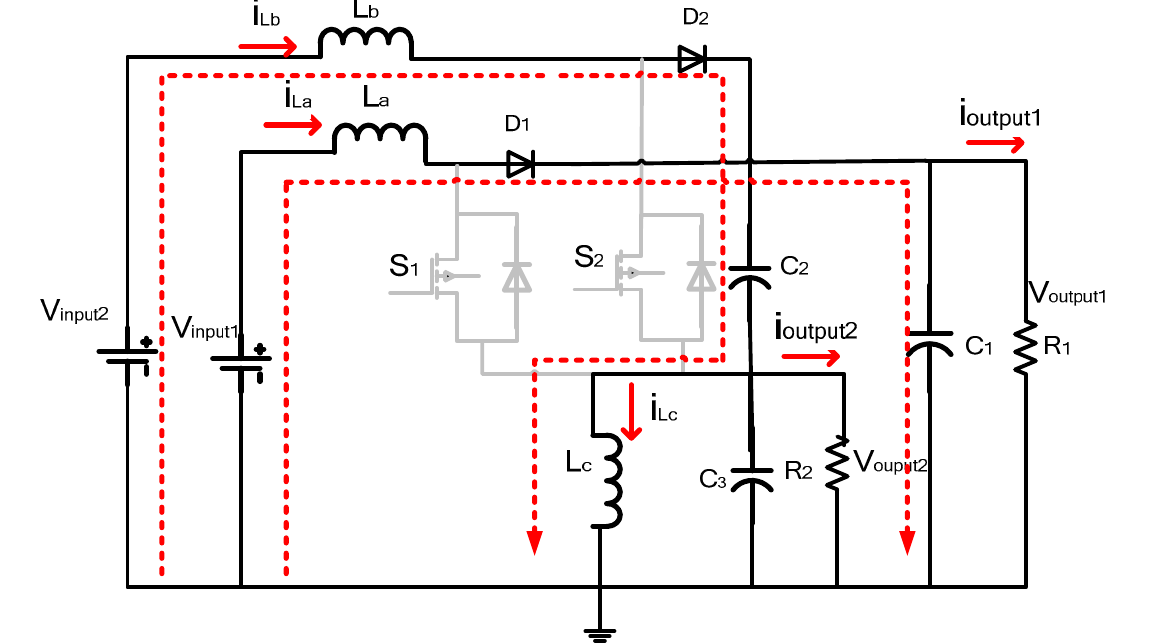
Figure 5. Mode 3 operation ( ---- Current flow direction).